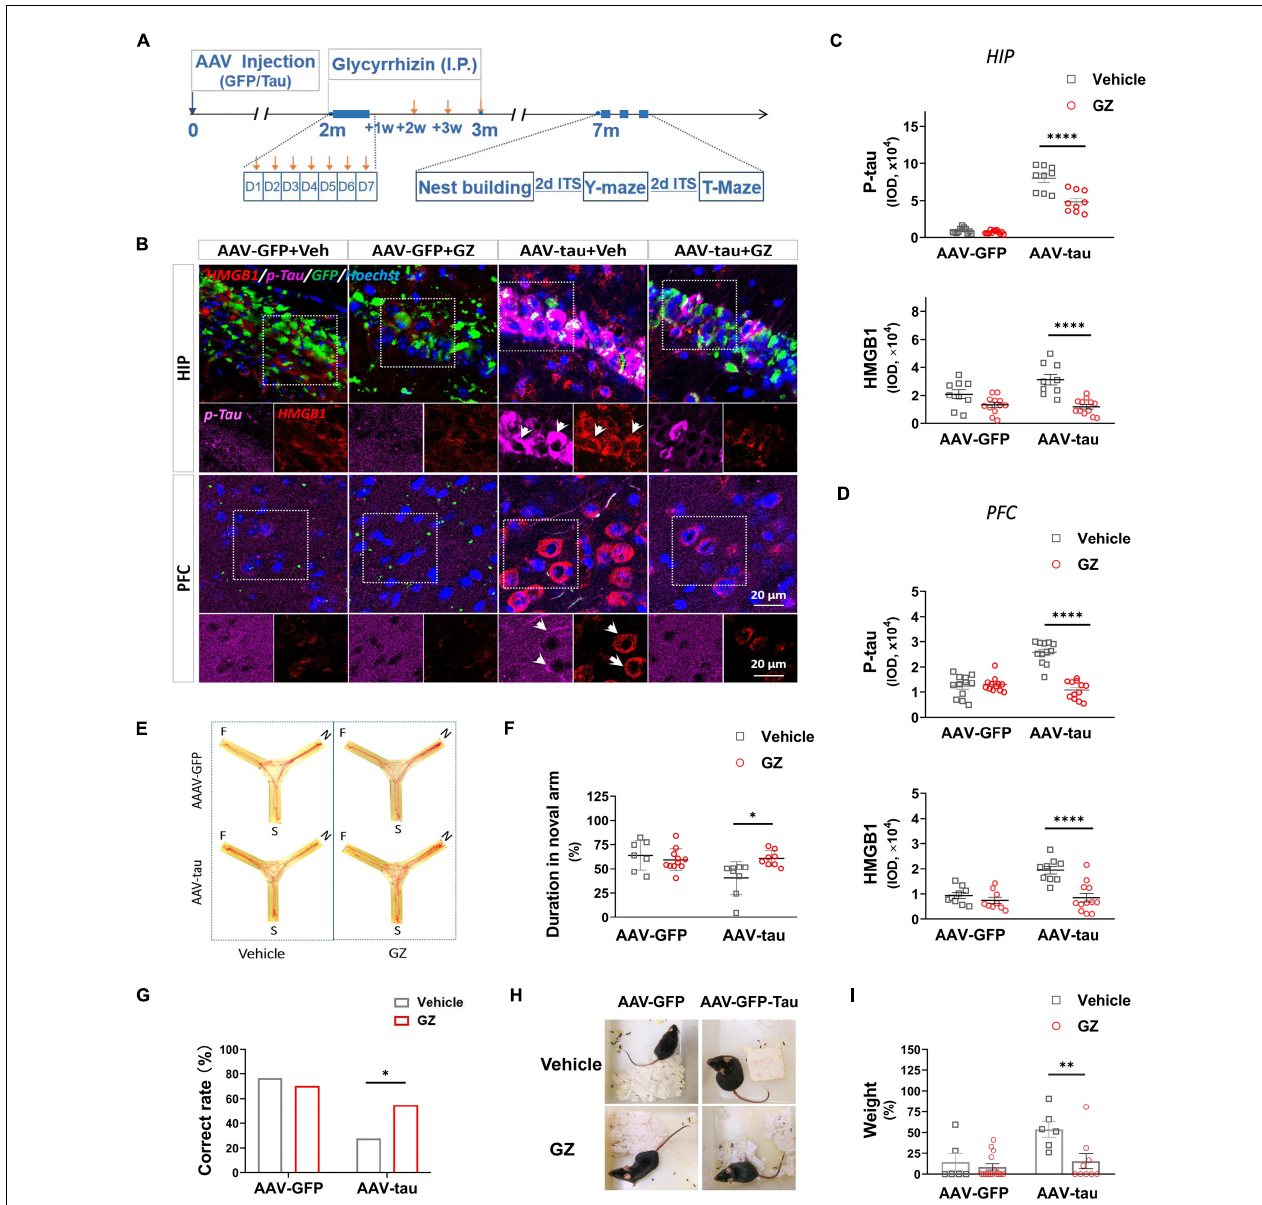
FIGURE 7 | High mobility group box-1 inhibitor alleviated tau pathology and improved spatial cognition in mice with p-tau overexpression. (A) Experimental procedure and drug administration schemes. Glycyrrhizin (GZ, 25 mg/kg i.p.), a pharmacological inhibitor of HMGB1, or vehicle was administered 2 months after virus injection, and orange arrows indicate the injection time. (B) Representative images of p-tau (ser404) and HMGB1 in the HIP and PFC from mice receiving AAV-tau or AAV-GFP 7 months after injection. White arrows indicate positive staining for p-tau or HMGB1. (C,D) Quantifications of p-tau (top) and HMGB1 (bottom) immunostainings (9 ∼ 12 ROIs from three mice for every group) in the (C) HIP and (D) PFC shown in panel (B) . (E) Representative moving tracks and the percentages of duration in (F) novel arm in GZ or vehicle-treated mice that received AAV-tau ( n = 8) or AAV-GFP ( n = 7 for vehicle and n = 11 for GZ) injections in the Y-maze test. (G) GZ improved the performance of p-tau-overexpressed mice in the T-maze test. (H) Representative nest pictures and (I) weight analysis of the cotton pads used for nest building showed GZ decreased the weight percentage of untorn cotton in mice that received AAV-tau injections. (G) Two-way ANOVA and (C,D,F,I) Pearson chi-square test were performed, ∗ p < 0.05, ∗∗ p < 0.01, ∗∗∗∗ p <